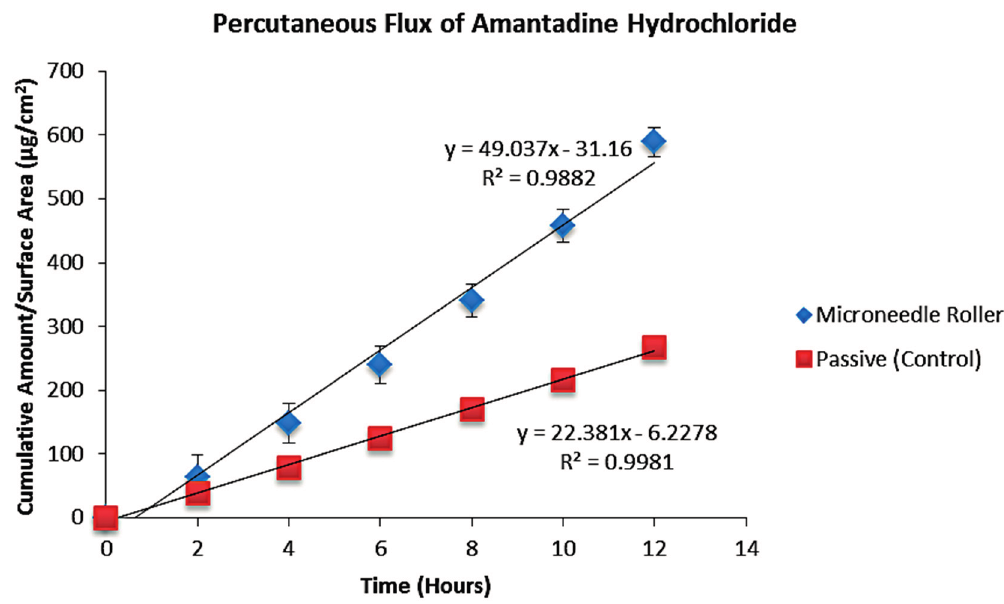
Figure 4. In vitro transdermal permeation of passive and microneedle-facilitated amantadine hydrochloride after microneedle roller application across porcine ear skin (500 μ m length, 540 needles per square centimeter density).